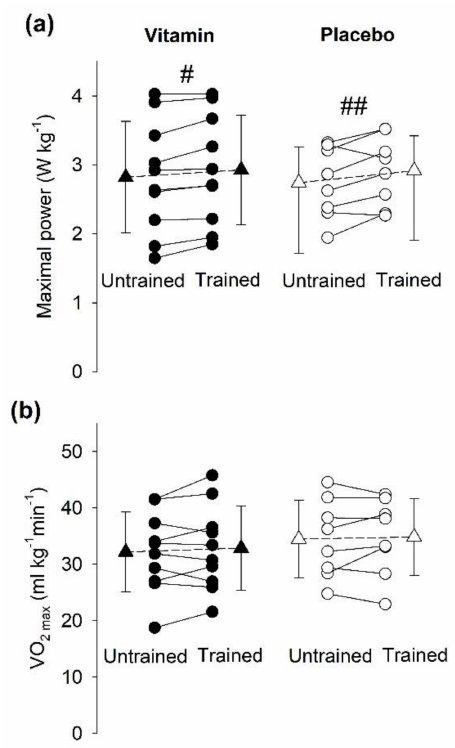
Figure 6. Three weeks of SIT increased power at exhaustion but not VO 2max . ( a ) Maximal power reached at task failure and ( b ) VO 2max during an incremental cycling exercise test prior to the first SIT session (Untrained) and two days after the last SIT session (Trained). Individuals were either treated with vitamins (black symbols; n = 10) or placebo (white symbols; n = 8). Data from each